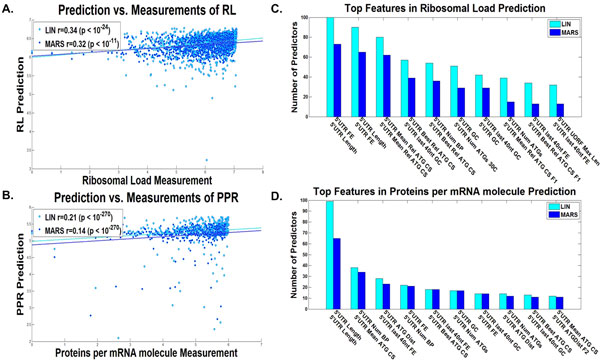
5'UTR linear and non-linear predictors results. Dot plot of the predictions vs. estimated measurements for the validation set of the predictor with the median results for the A. ribosomal load, and B. proteins per mRNA molecule, for the 5'UTR linear (LIN) and non-linear (MARS) predictors (Additional file 1: Supplementary Methods). The best features according to the number of predictors they participated in (Additional file 1: Supplementary Methods) of the C. ribosomal load predictor, and D. proteins per mRNA molecule predictor, for the 5'UTR linear (LIN) and non-linear (MARS) predictors (Additional file 1: Supplementary Methods).